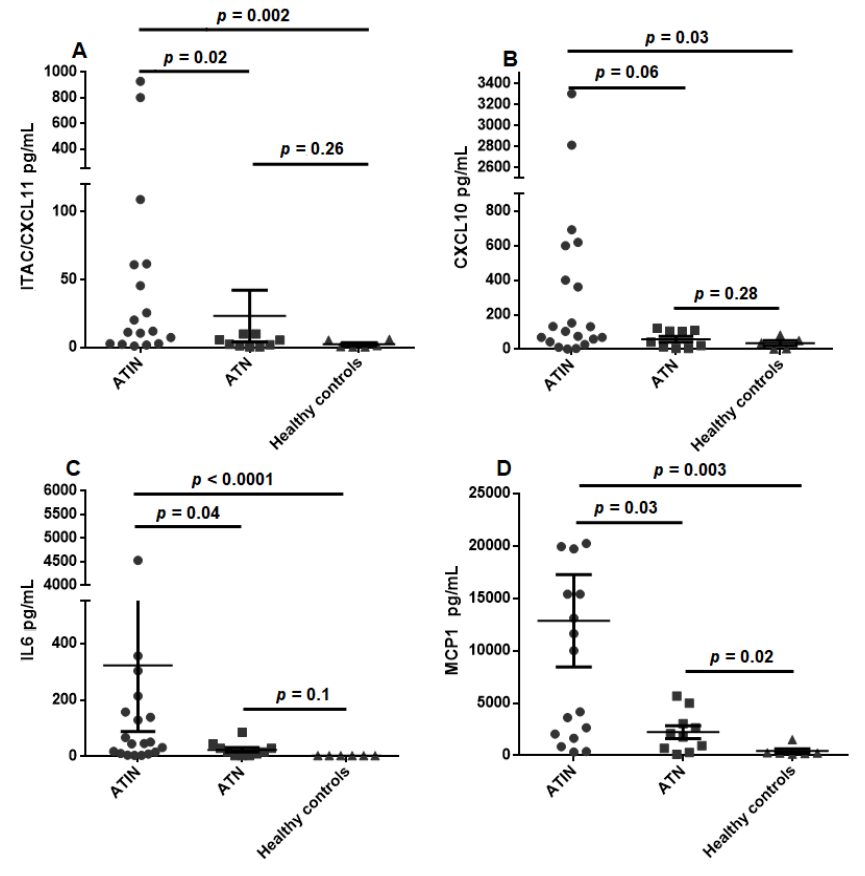
Figure 1. Urinary levels of CXCL11 (Panel A), CXCL10 (Panel B), IL-6 (Panel C) and MCP-1 (Panel D) in acute tubulointerstitial nephritis and acute tubular necrosis patients, and healthy controls. ATIN — acute tubulointerstitial nephirits, ATN — acute tubular necrosis.